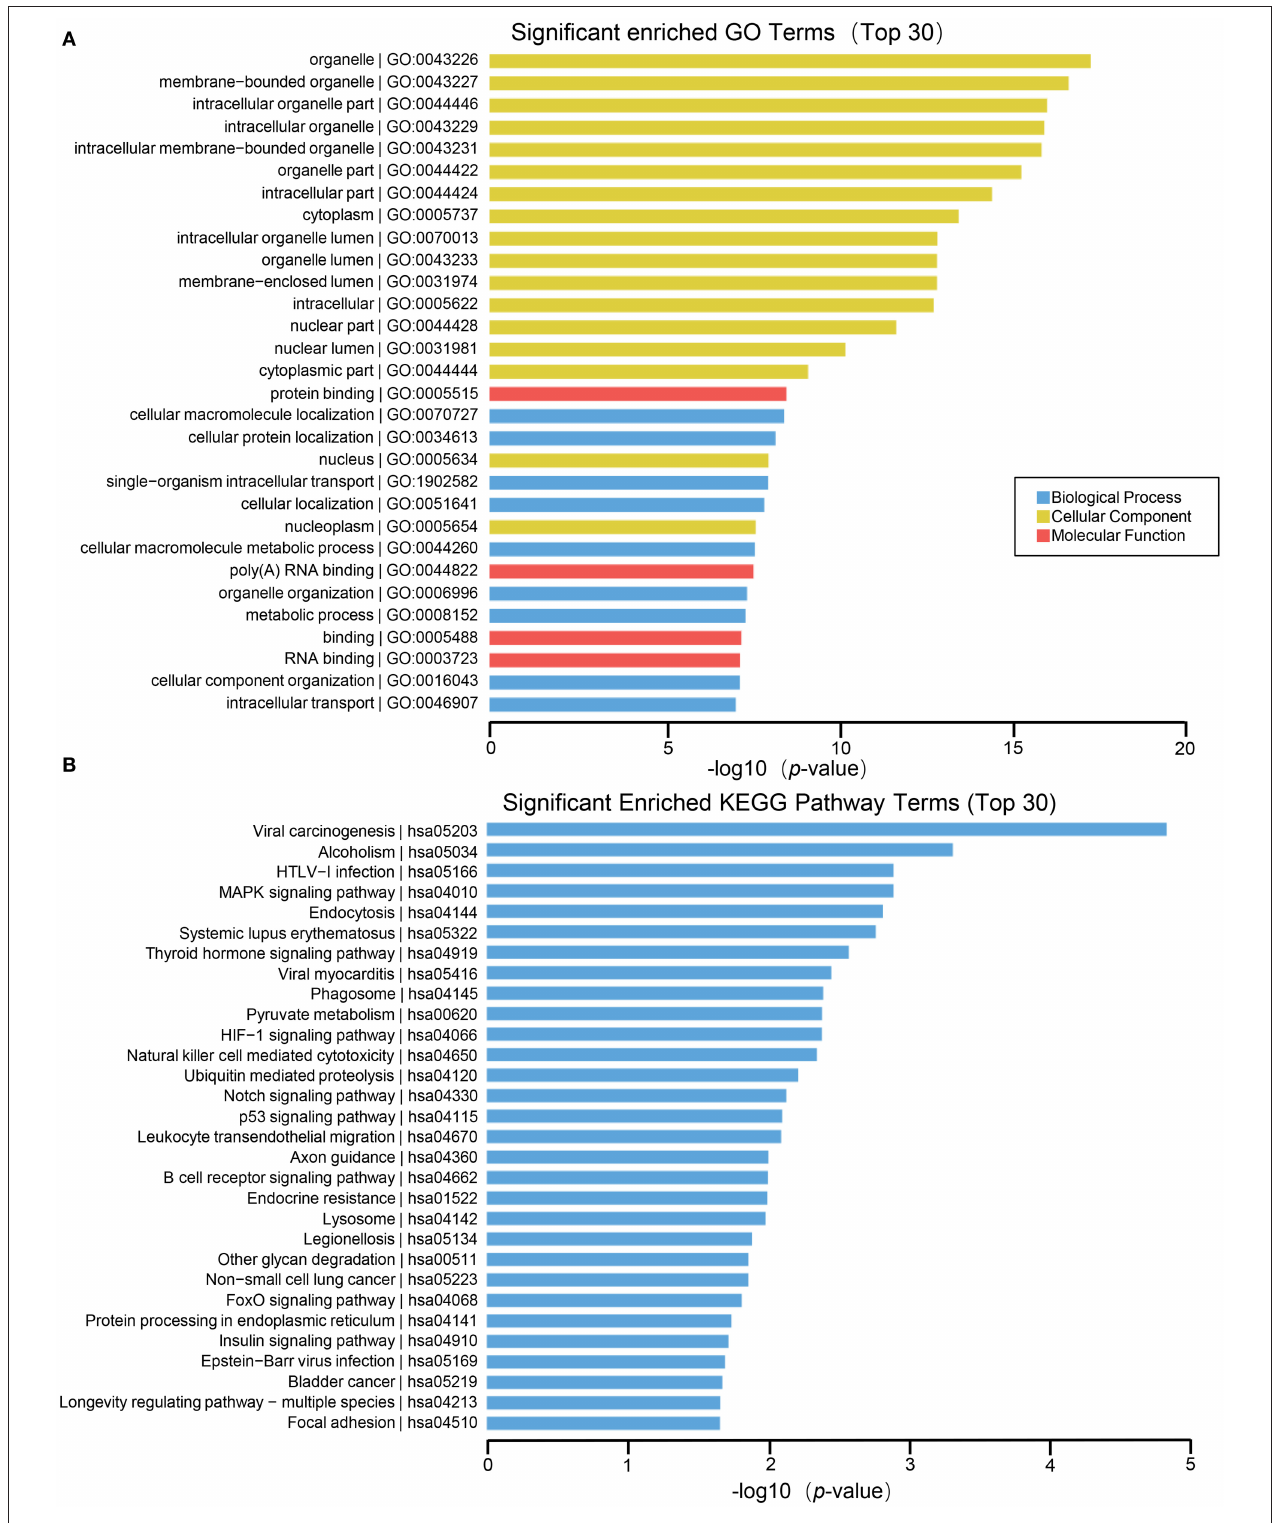
FIGURE 5 | GO and KEGG pathway analysis on the results of mRNAs. (A) Gene ontology analysis. Top 30 GO terms for the difference in mRNA between HT group and non-HT group. (B) KEGG pathway analysis. Top 30 pathways for the difference in mRNA between HT group and non-HT group.